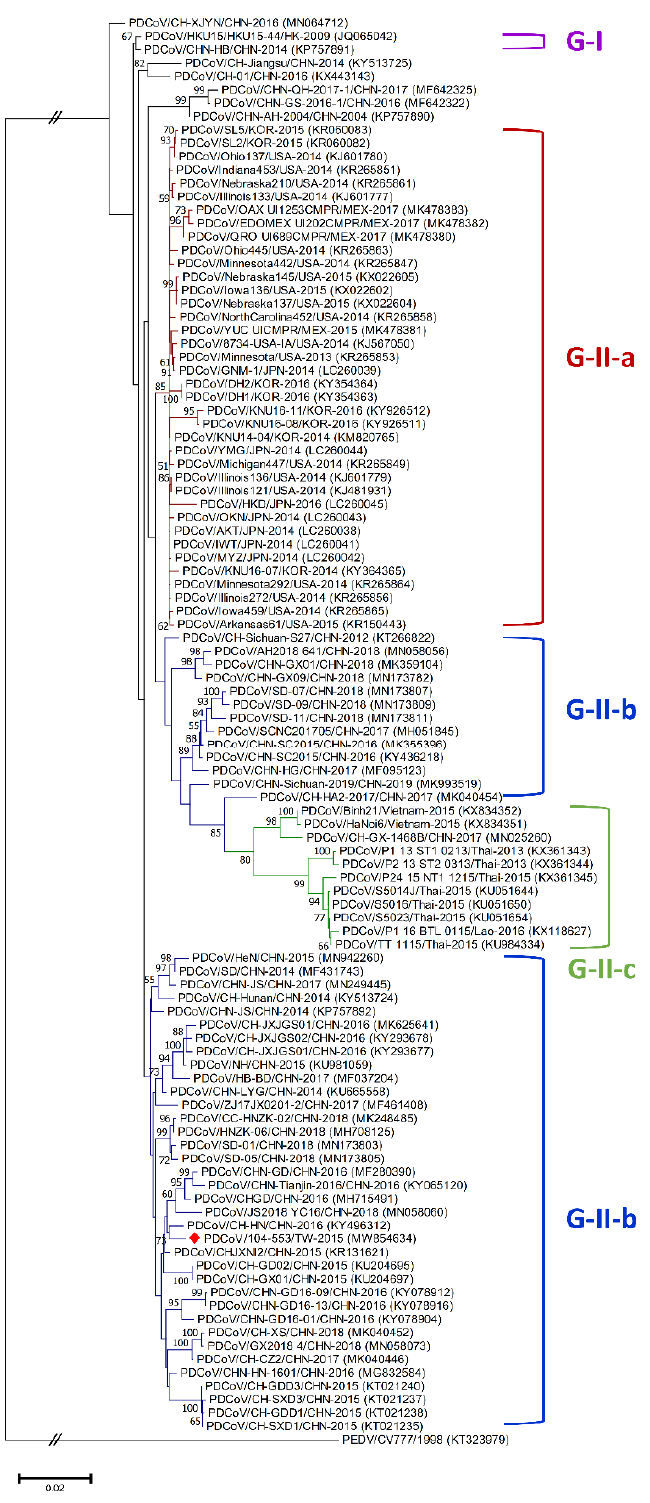
Figure 2. Phylogenetic trees based on the completed S gene sequences of PDCoV strains were constructed by the maximum likelihood estimation (MLE), using the Kimura 2-parameter (K2P) model. Horizontal branch lengths indicate genetic distances among various strains from different genogroups, labelled in different colors. The red solid diamond represents the local PDCoV strain in 2015. The scale bar indicates nucleotide substitutions per